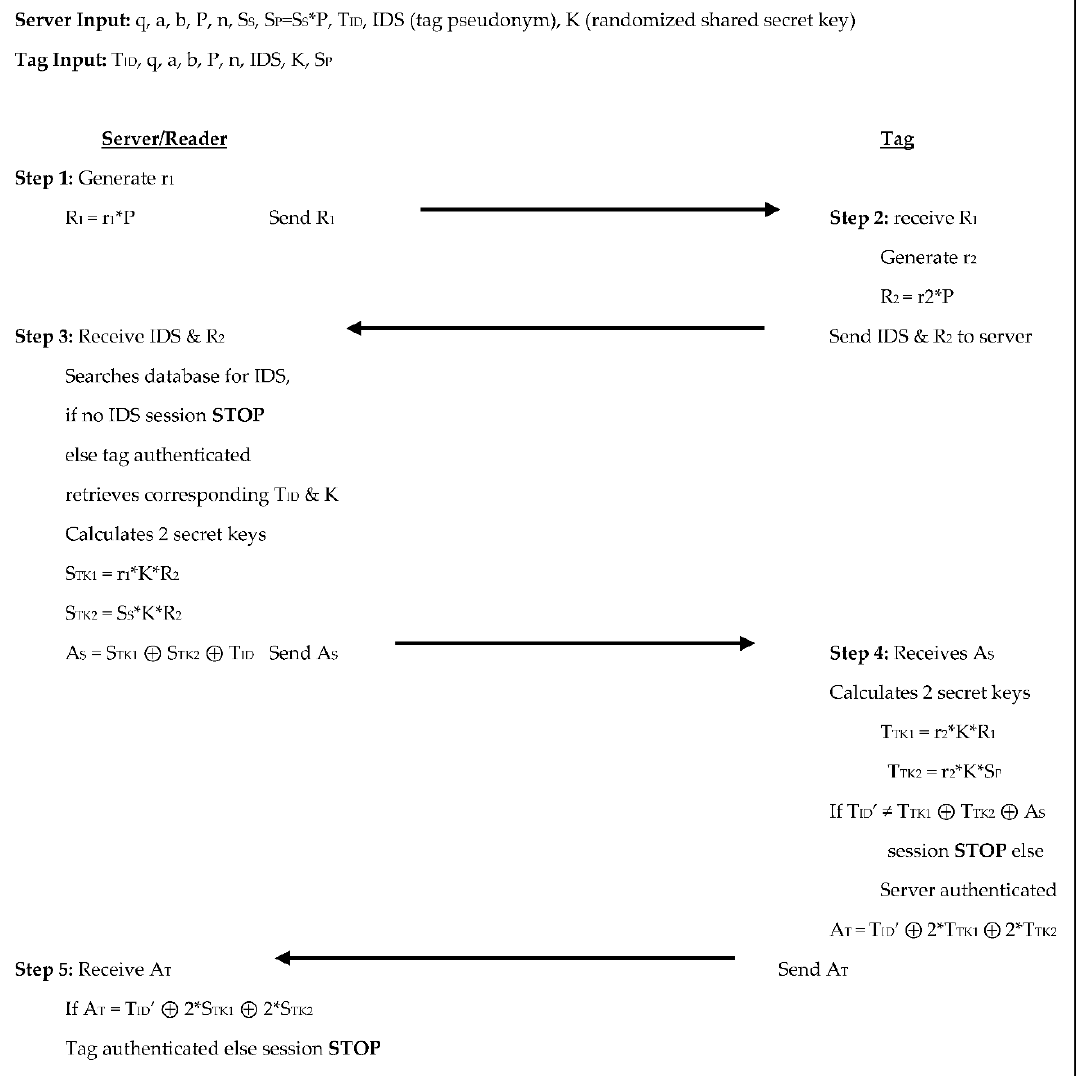
Table 1. Comparison of scalar multiplication costs in each protocol.